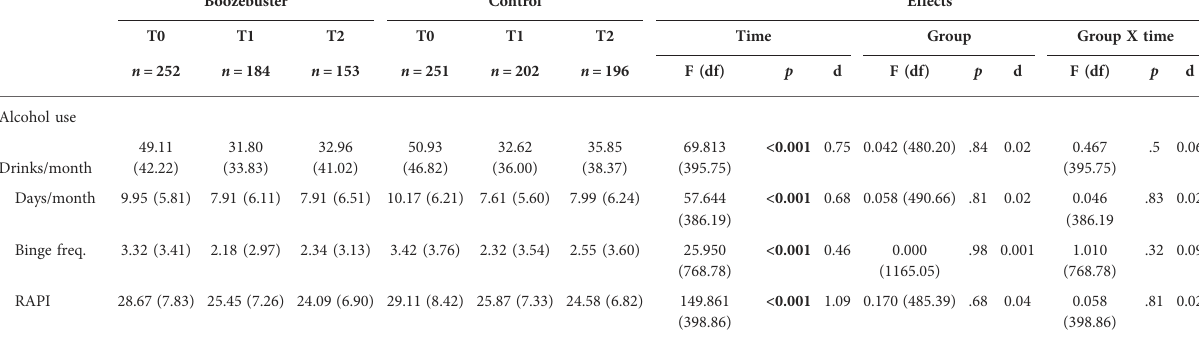
TABLE 3 Effect of Boozebuster app on primary and secondary outcome measures.